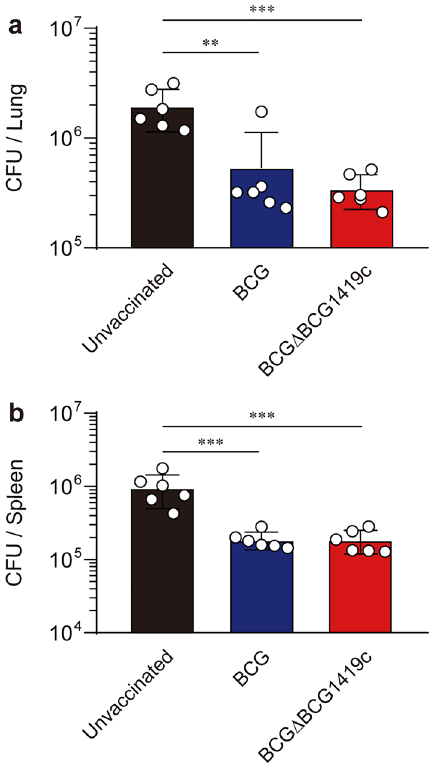
Figure 2. Long-term protective efficacy against replication of Mtb strain M2 with BCG and BCGΔBCG1419c vaccination. ( a , b ) CFUs in the lungs and spleens of each subset of mice ( n = 6/group) at 10 weeks post-infection were assessed by enumerating viable bacteria. Fold change was presented by comparing the mean CFU values between group. One-way ANOVA with post hoc Tukey’s multiple comparison test was used to evaluate the significance. ** p < 0.01 and *** p < 0. 001. The experimental results of one representative experiment are